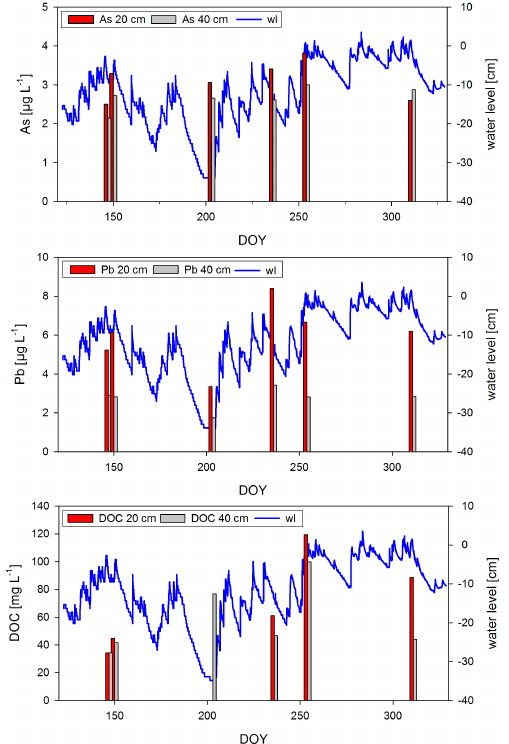
Figure 6. Pore water concentrations of As (top), Pb (middle) and DOC (bottom) at 20 and 40cm depth over time. The blue line indi- cates the recorded bog water level